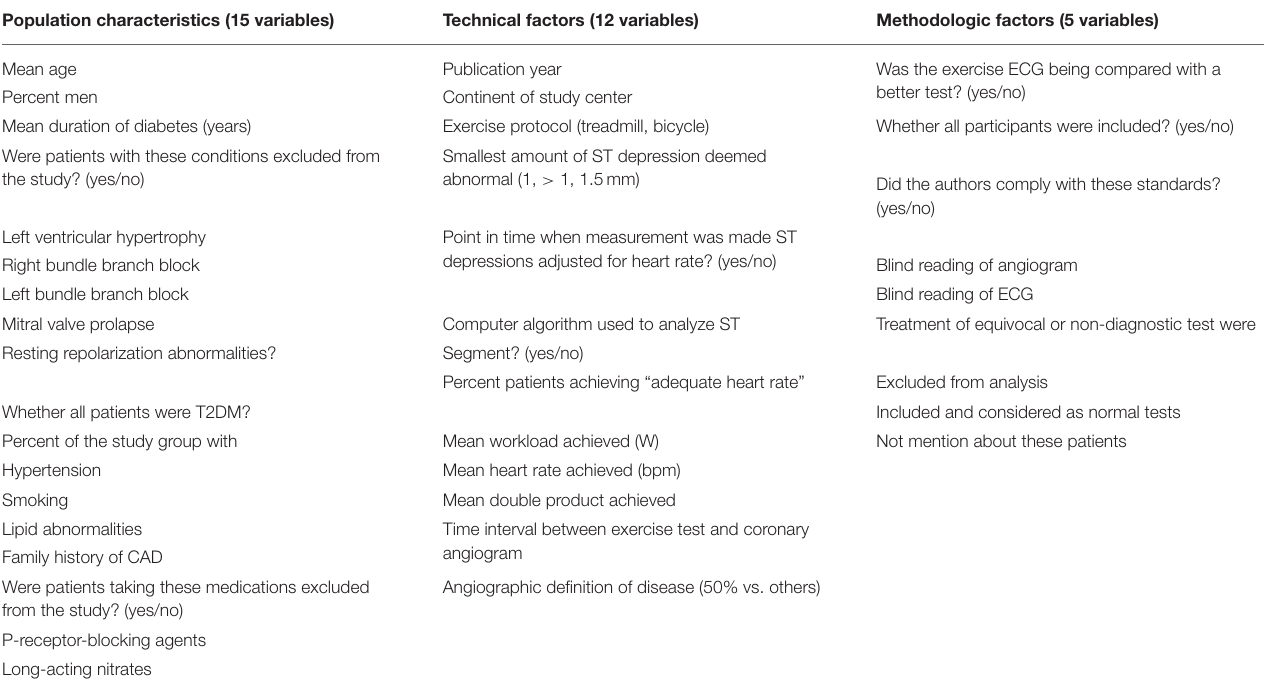
TABLE 1 | Variables abstracted from exercise stress testing literature.